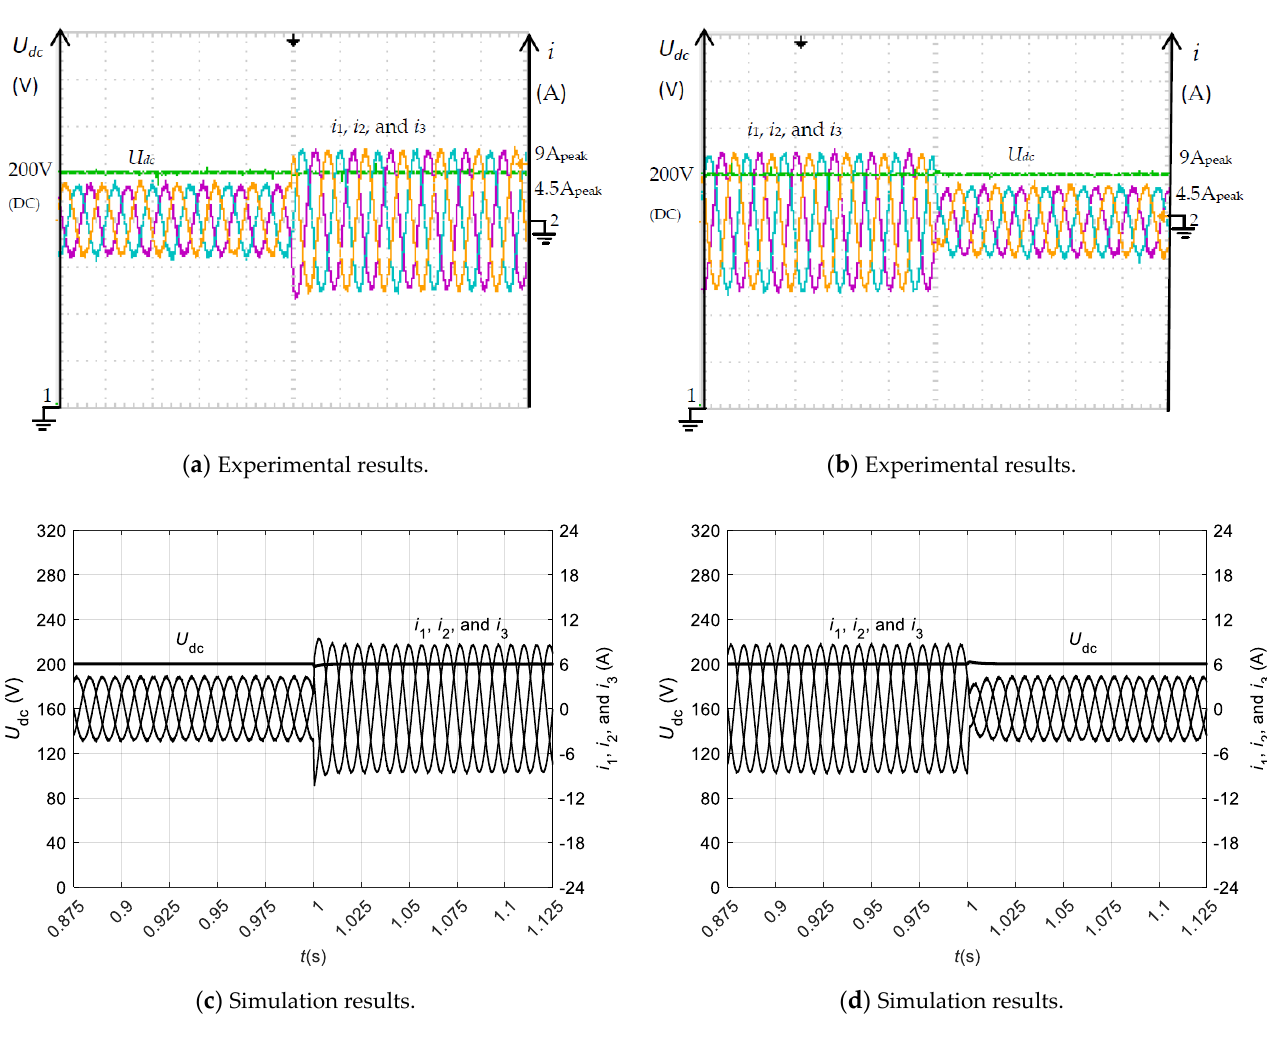
Figure 8. Experimental and simulation results of the DC voltage and AC currents, i 1 , i 2 , and i 3 , of the DC microgrid when there is a step change in load or generation. ( a,c ) Increased load or decreased generation. ( b,d ) Decreased load or increased generation. Vertical: 6 A/div and 40 V/div. Horizontal: 25 ms/div.